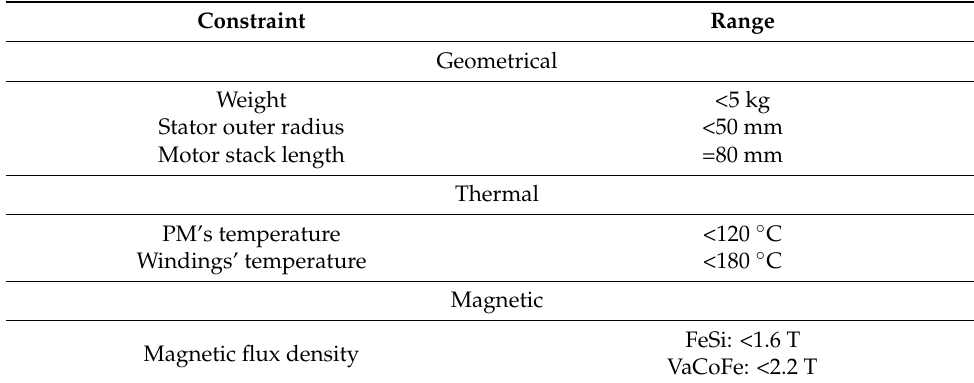
Table 2. Optimization constraints by type and respective ranges. Constraint Range Geometrical